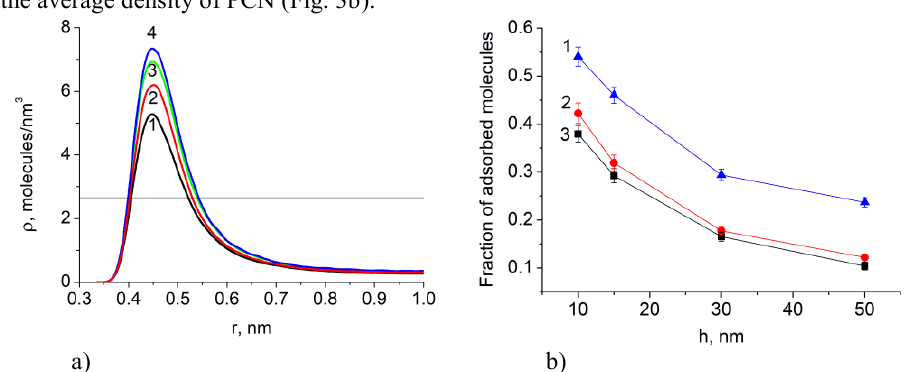
Fig. 3. (a) The density distribution of PCN molecules near the wall of nanopores of various sizes. Curve 1 – 10 nm pore width, 2 – 15 nm, 3 – 30 nm, 4 – 50 nm. r is the distance from the nanopore wall. The average density of PCN in nanopores is 0.35 molecules/nm 3 . (b) The dependence of the fraction of adsorbed PCN molecules on the width of the slit-shaped nanopores for different values of the average density of the molecules contained in them. Curve 1 – the average density in the pore is 0.035 molecules/nm 3 , 2 – 0.175 molecules/nm 3 , 3 – 0.35 molecules/nm 3 , h is the nanopore